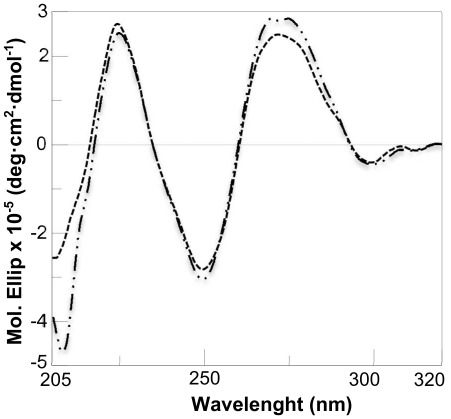
CD of triplexes.CD spectra of (PNA S)2DNAc (–), (PNA)2DNAc (–) in 10 mM Na Phosphate buffer, 100 mM NaCl, 5 mM MgCl2, pH 7 at 3 µM triplex concentration.